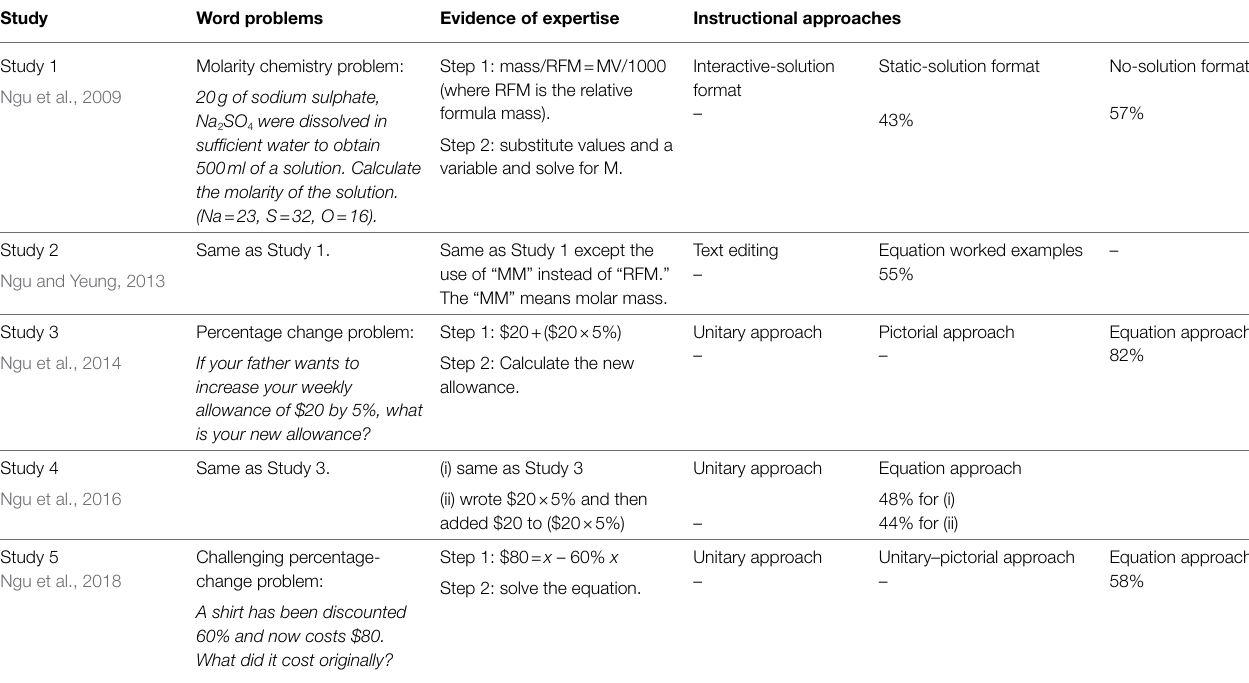
We only included data that are related to the use of the algebra approach for learning word problems.